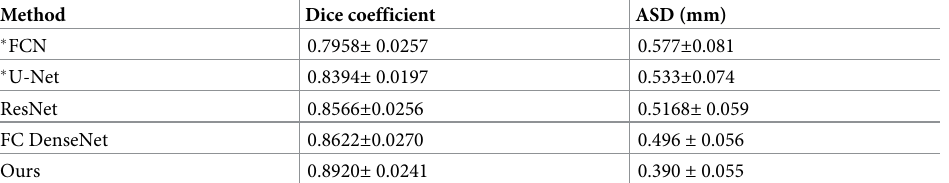
Table 3. Comparison of frontal gyrus, hippocampus, amygdala, caudate nucleus, thalamus segmentation results on the ABCD dataset.